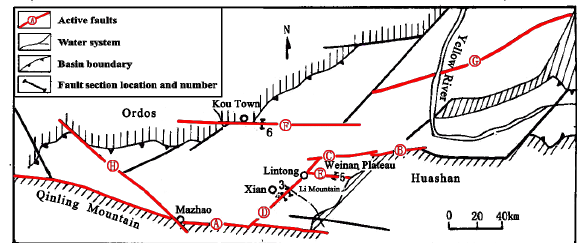
Figure 1. Schematic diagram of the location of major active